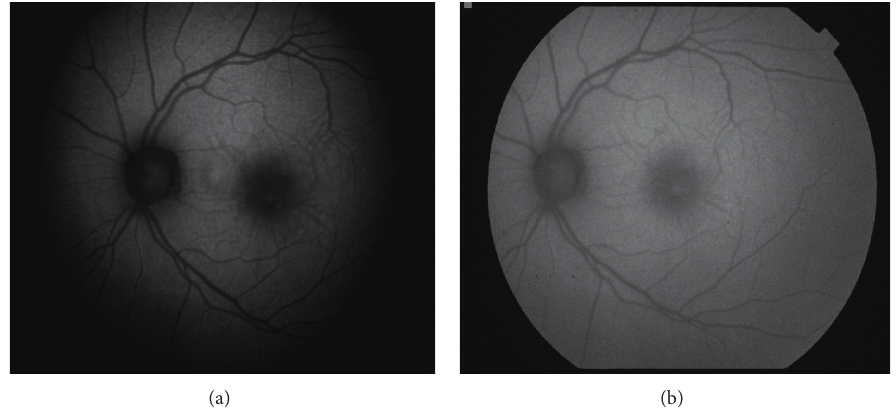
Figure 1: Macular star photographed with the Carl Zeiss camera (a) and the Topcon camera (b). Notice more marked difference between light gray and dark gray for the Carl Zeiss and the better defined mask for the Topcon.